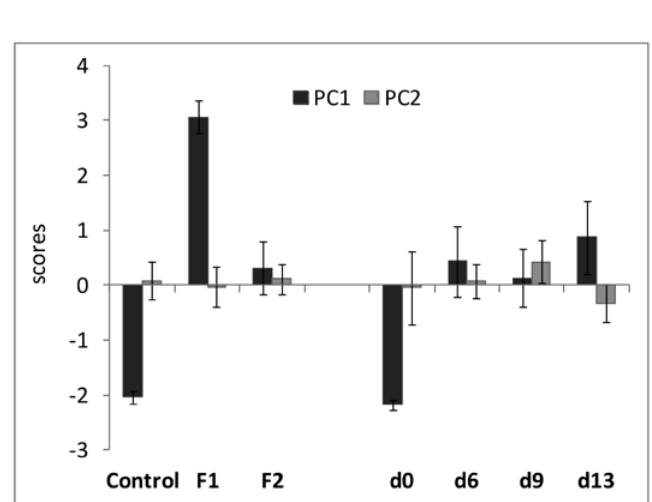
Fig. 5 - PCA of E-nose data: loadings and scores of PC1 versus PC2 ac- cording to coating treatment (control; coated=F1, F2) and day at 13°C (d0, d6, d9, d13 refers to arrival, after 6, 9 and 13 days at 13°C, respectively).